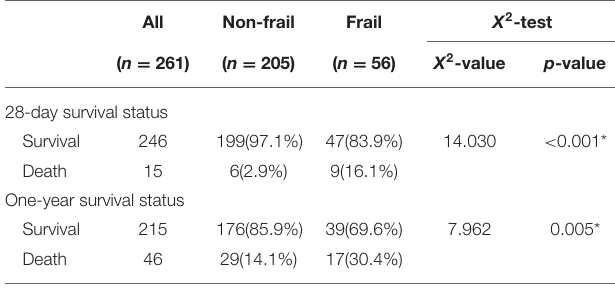
TABLE 2 | Survival status for 28-day and 1-year follow-up for survival analysis.